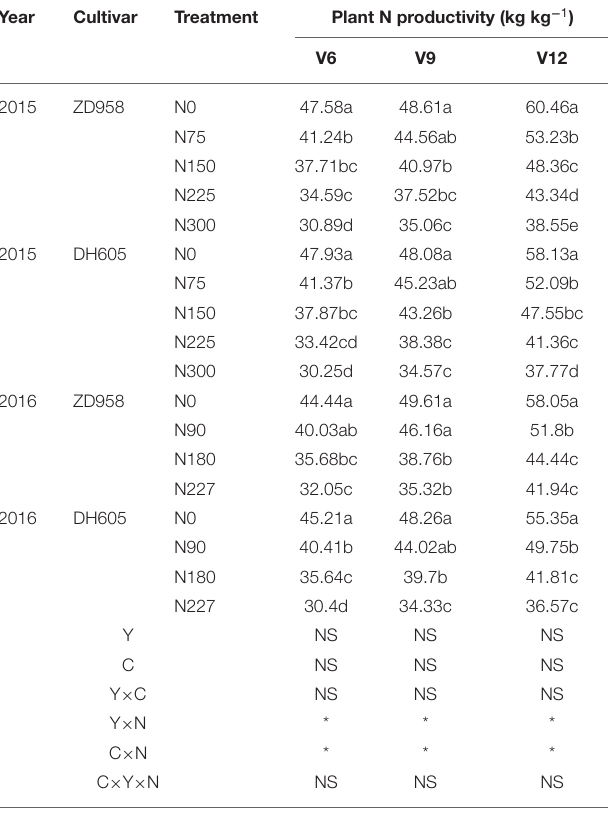
TABLE 3 | Plant N productivity of two corn cultivars at the three growth stages under five N levels during the 2015 and 2016 seasons.